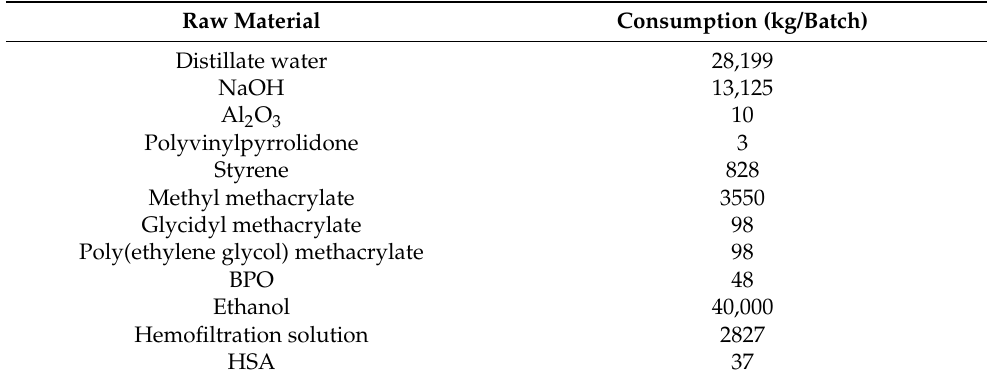
Table 6. Raw materials consumption for the synthesis of HSA functionalized St-MMA-GMA- PEGMA